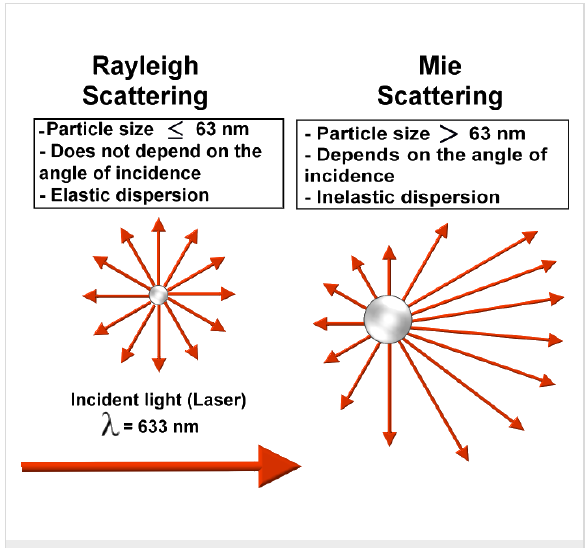
Figure 13: Schematic representing the differences between Rayleigh (left) and Mie (right) light scattering theories.